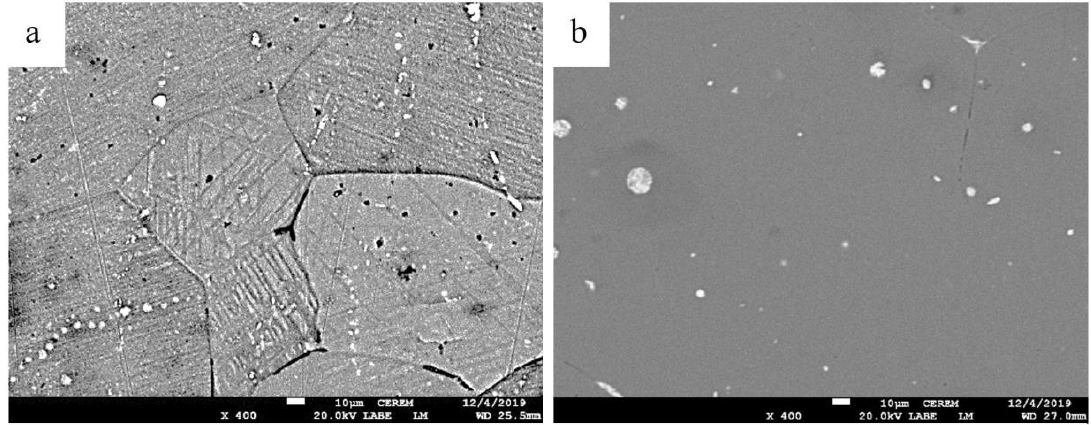
Figure 3. Scanning electron microscopy (SEM) analysis of ( a ) H-0.4Mg and ( b ) L-1.4Mg alloys at peak-aged state.